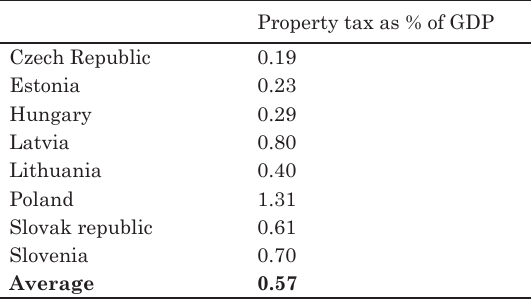
table 4. Property tax as % of GDP for CEE Countries,